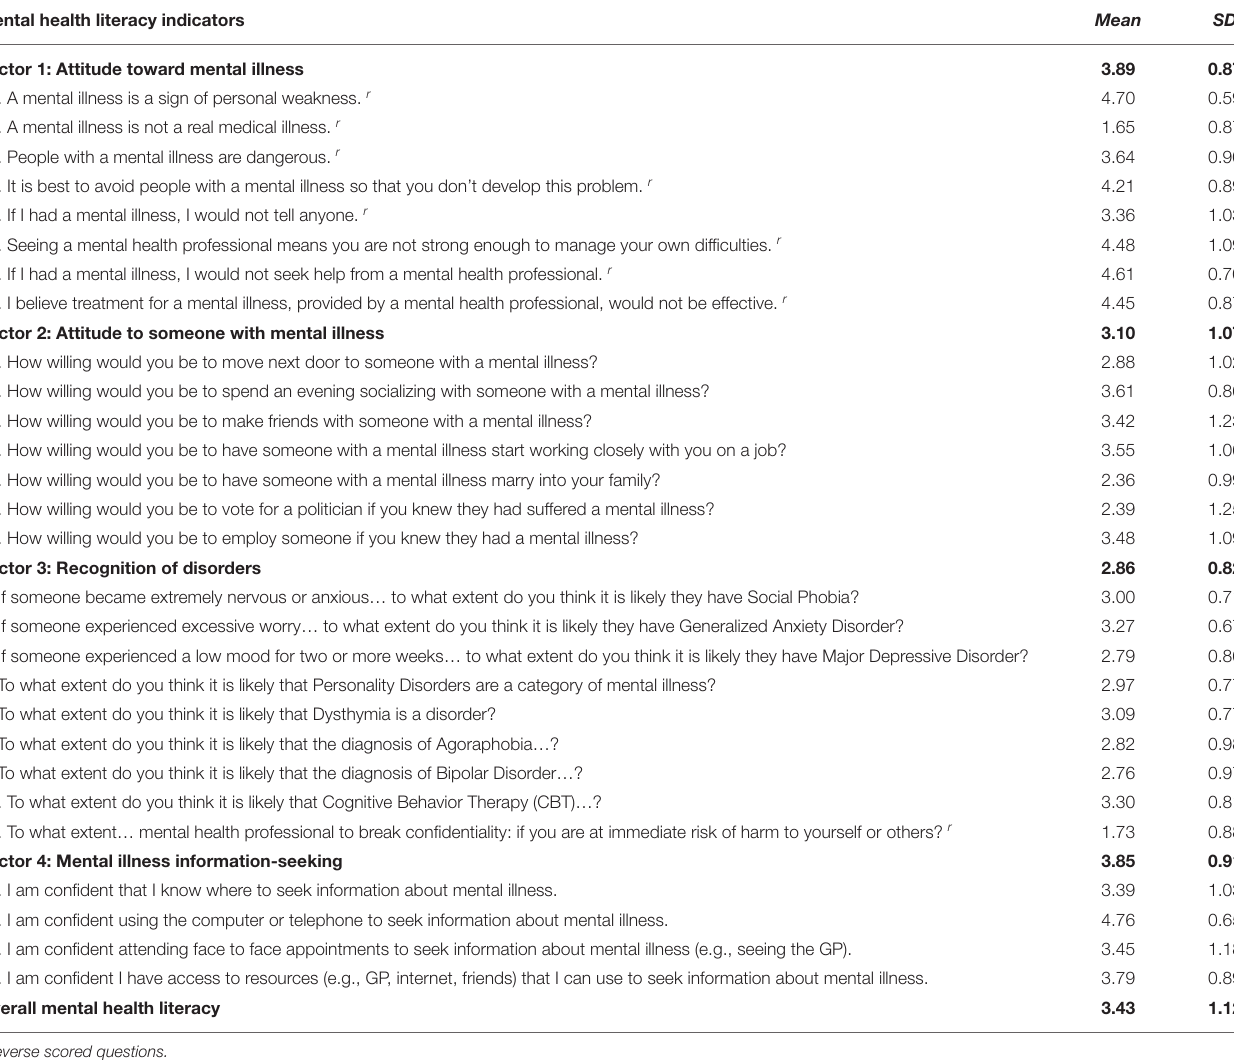
TABLE 6 | Relationship between the demographic characteristics of university students and their mental health literacy ( N = 339). Variables r Unstandardized coefficients Standardized